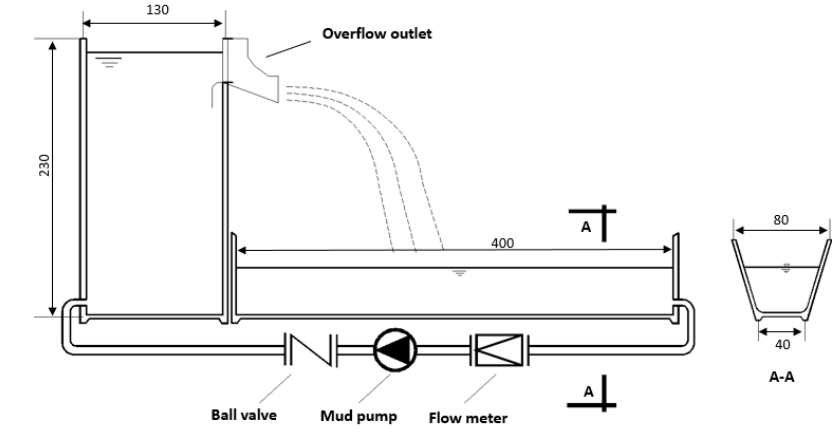
Figure 1. Model arrangement (Unit = cm).